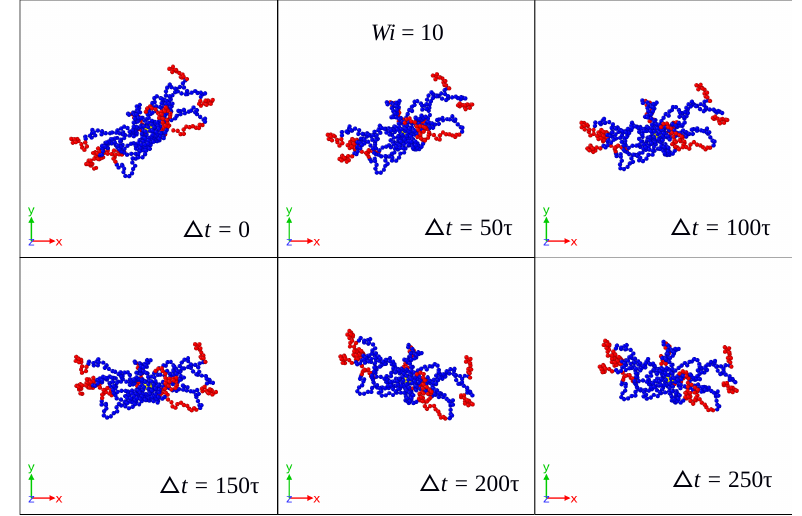
Figure 2. Time evolution of the (fixed) reference configuration in Eckart’s frame as seen in the laboratory frame for Case 1 and Wi =